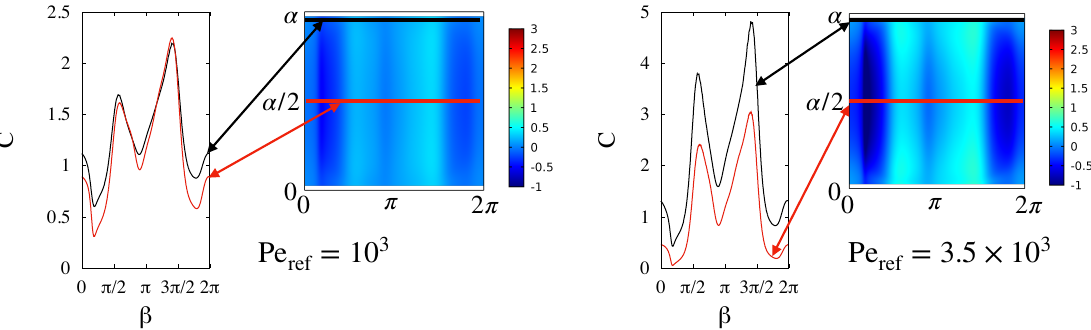
Figure 12. Steady state profiles of the cumulative particle concentration C ( x , t ) for r p = 0.025, d o = 0.8, tan − 1 θ l = 1/10 at Pe ref = 10 3 ( left panel ) and Pe ref = 3.5 × 10 3 ( right panel ). The red and black continuous curves depict the concentration profile along a circumference resulting from the intersection between the effective obstacle surface and the planes z = α /2 (symmetry plane) and z = α − r p (ceiling surface),